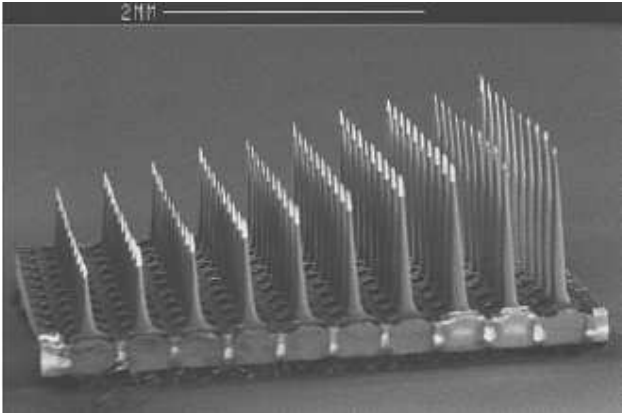
Figure 7 . Slanted microarray developed by Branner et al.